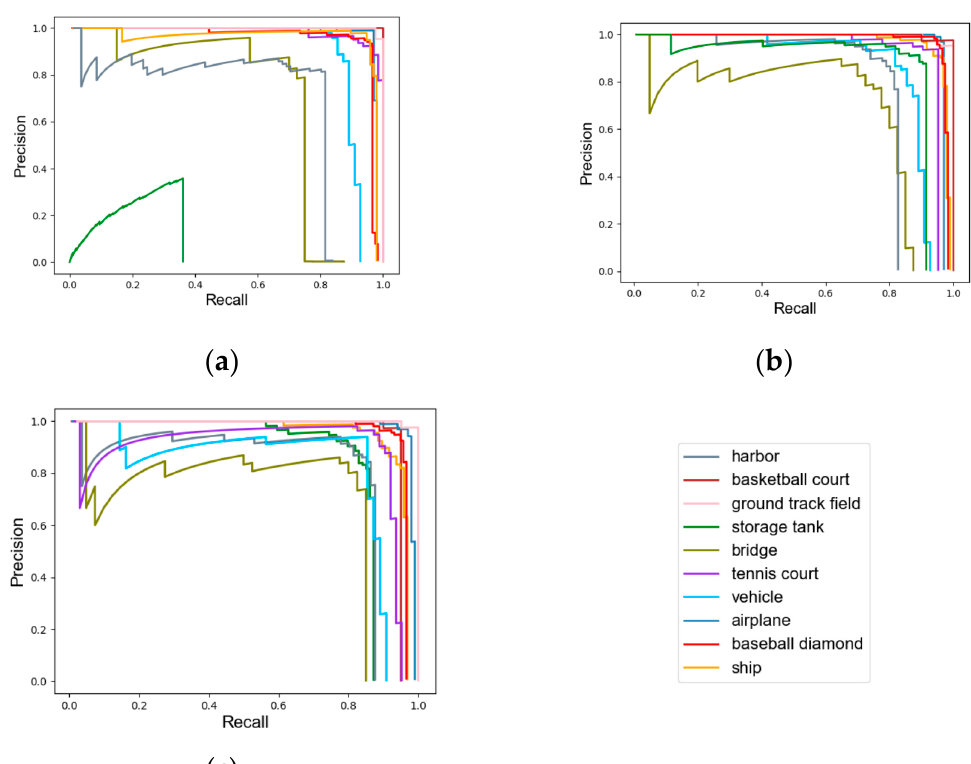
Figure 11. ( a ) The average precision (AP) values of the ten classes of the NWPU VHR-10 dataset obtained by the feature pyramid network (FPN) with the MS method (the first experiment). ( b ) The AP values of the ten classes of the NWPU VHR-10 dataset obtained by the SD-MS model (the second experiment). ( c ) The AP values of the ten classes of the NWPU VHR-10 dataset obtained by our shallow-deep feature extraction (SDFE) with MS-MF model (the third experiment).